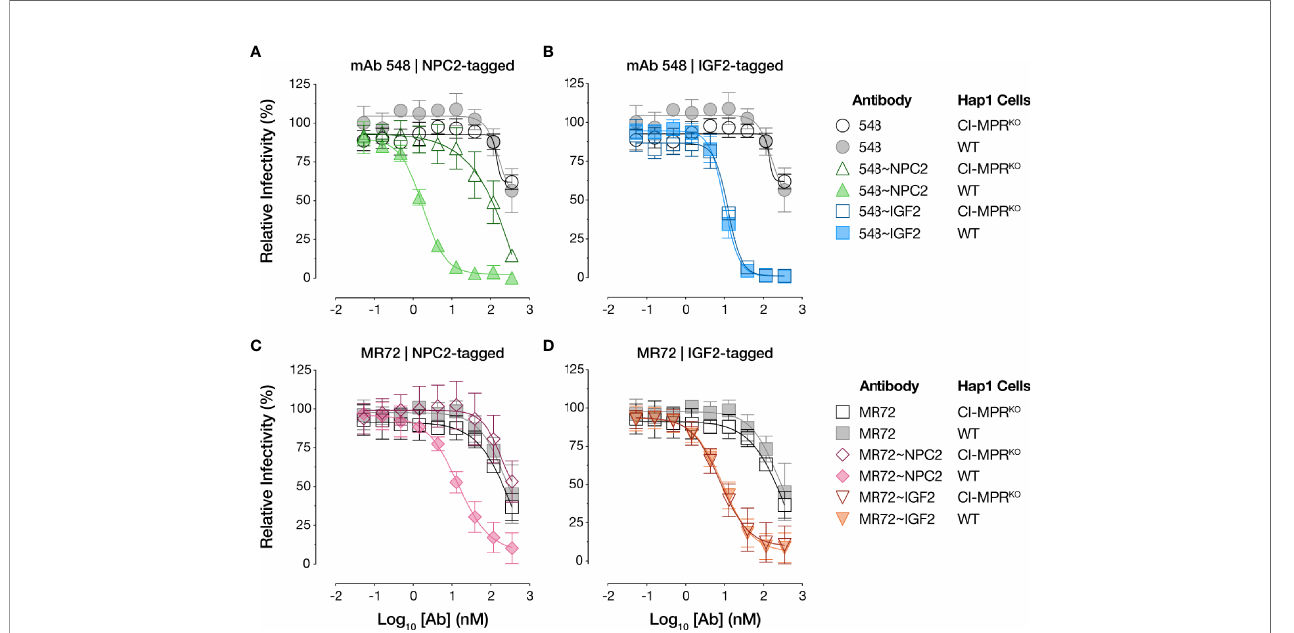
FIGURE 5 | NPC2- but not IGF2-tagged bsAbs lose neutralizing activity in CI-MPR knockout cells. Capacity of (A, C) NPC2-tagged and (B, D) IGF2-tagged bsAbs to neutralize rVSV-EBOV GP infection in isogenic haploid cell lines replete with or genetically de fi cient in CI-MPR (Hap1 and Hap1-CI-MPR KO , respectively). Infection was measured by automated counting of eGFP + cells and normalized to infection in absence of antibody. Means ± SD are shown for 5 – 8 replicates from 2 – 3 independent